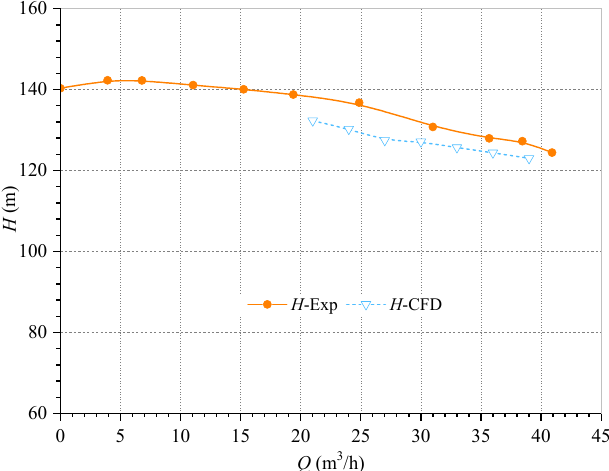
Figure 8. Comparison of numerical and experimental results.